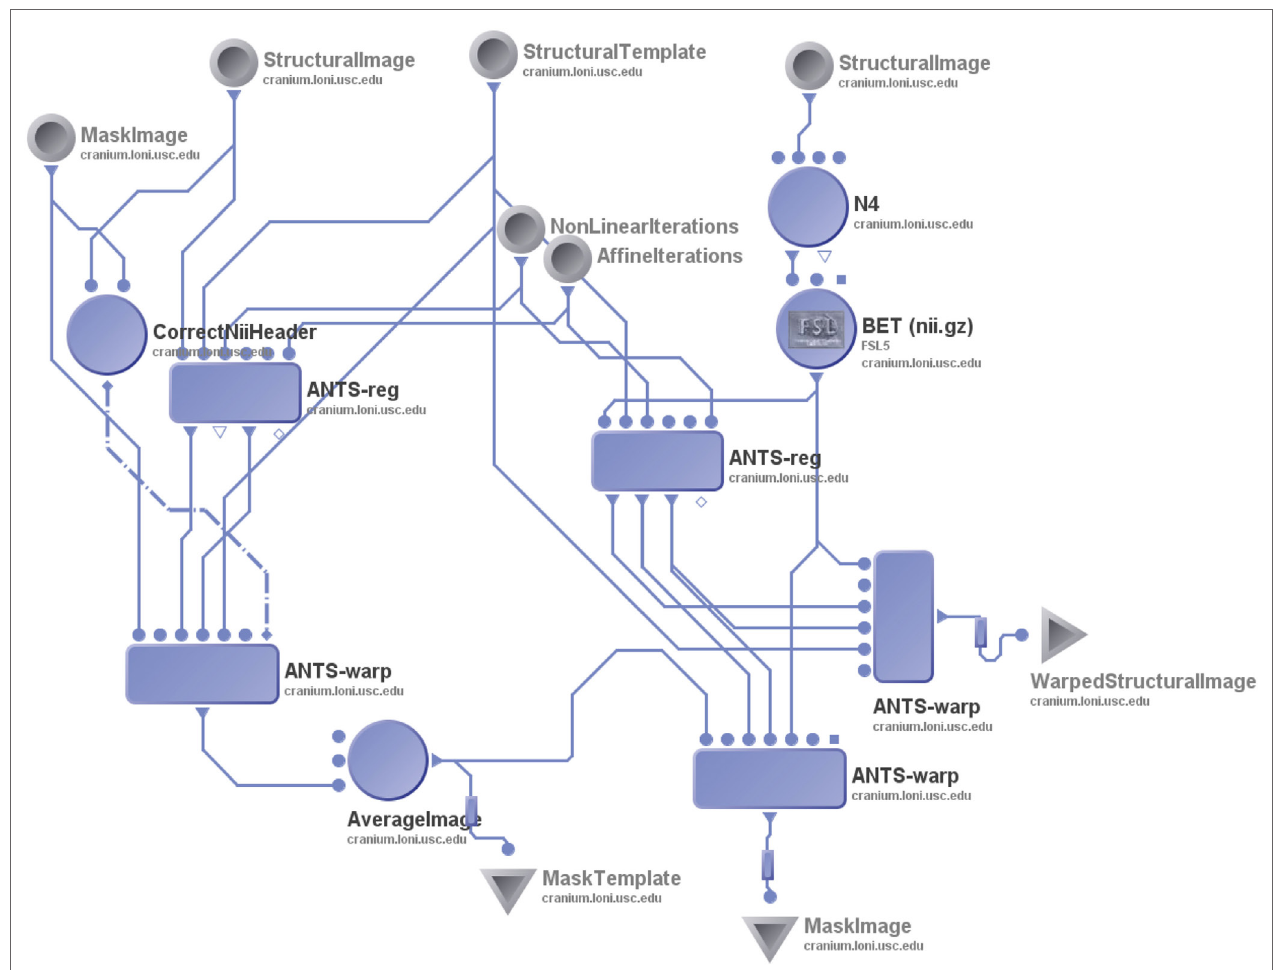
FigUre 3 | Pipeline workflow illustrating the automated segmentation process